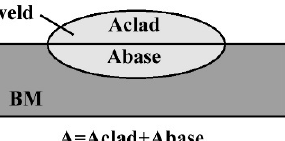
Figure 8. The schematic view of the methodology of dilution calculations; A—total molten area, A clad —molten cladded area and A base —molten area of BM.